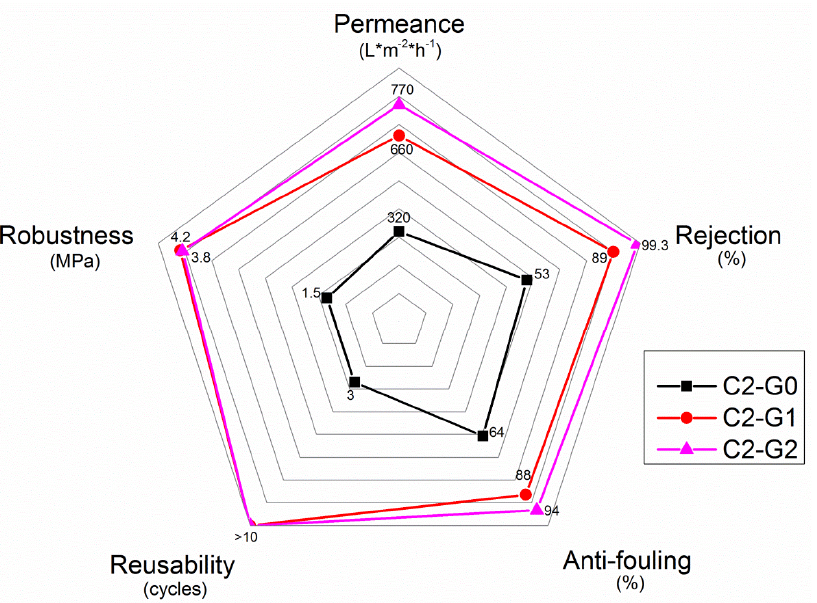
Figure 10. Radar-plot analysis of the overall performance of the membranes